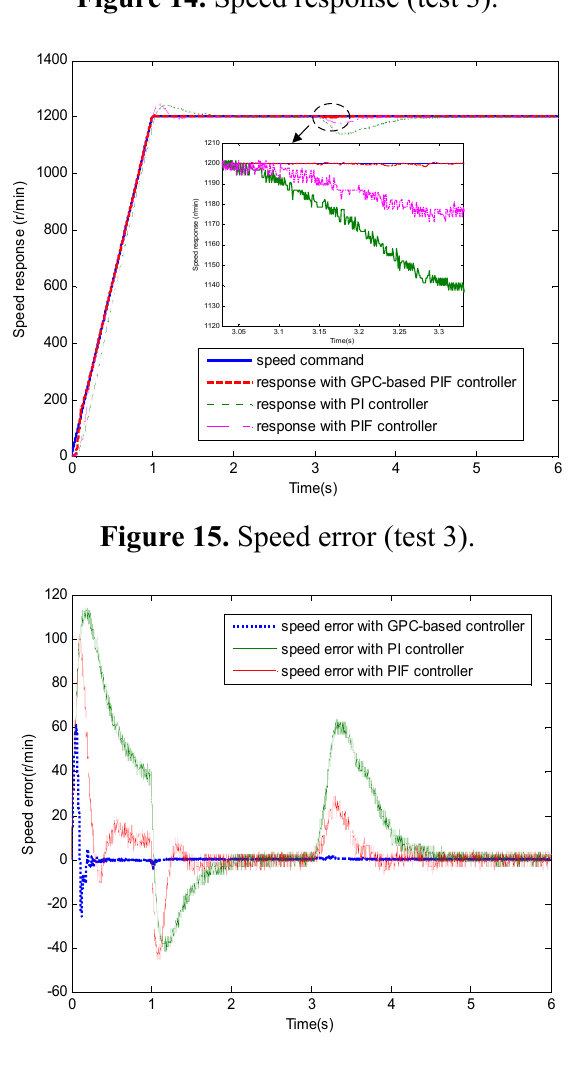
Figure 14. Speed response (test 3).